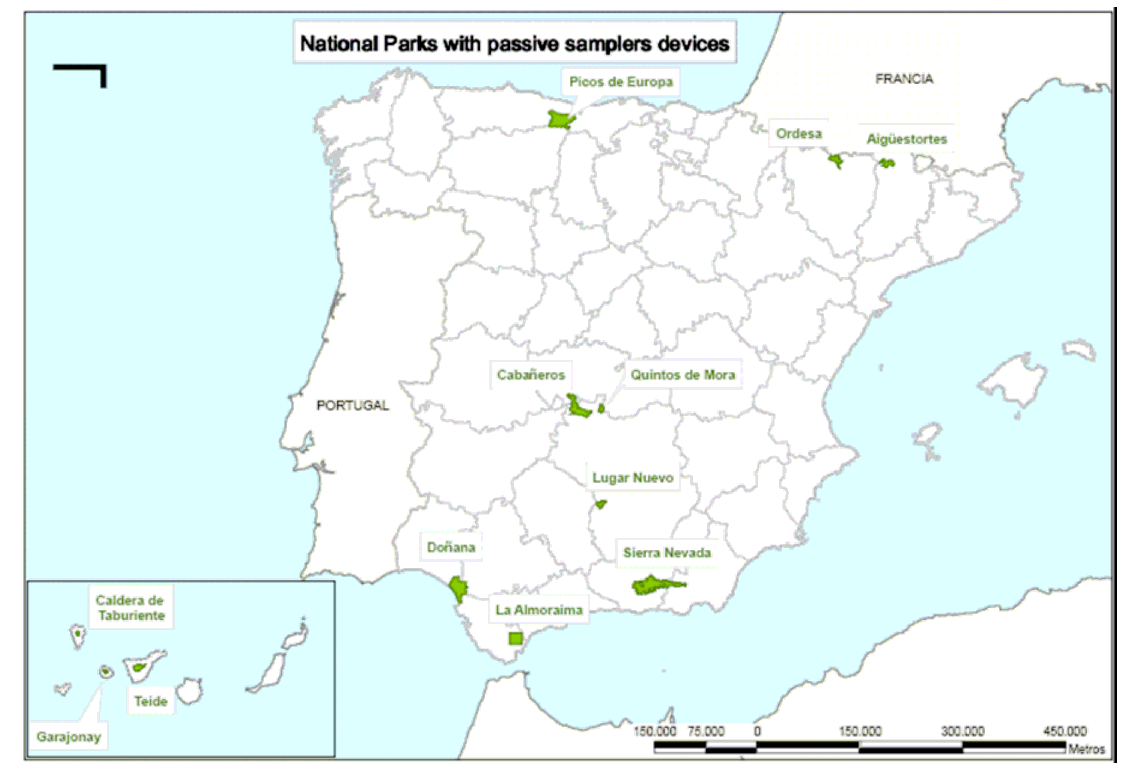
FIGURE 2. National parks and State protected lands within the network.